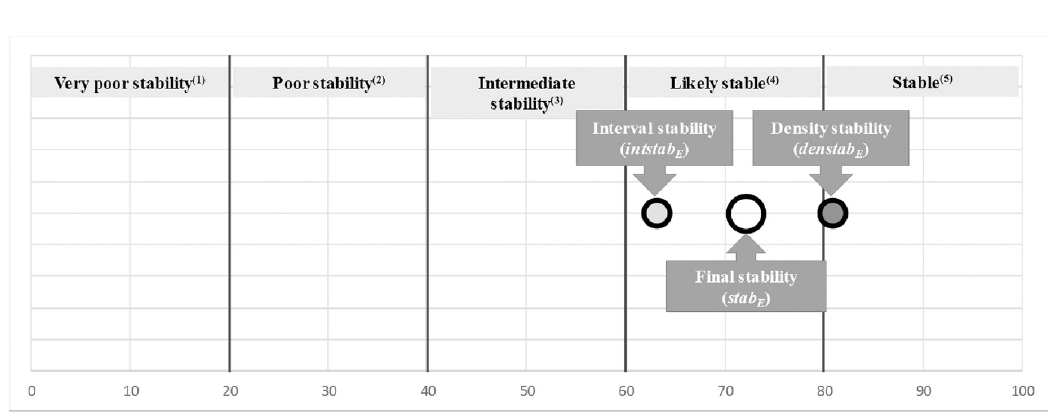
Fig 4. Interval stability ( intstab = 80.95, circle with the darker background), density stability ( denstab E light grey) and final stability ( stab E = 72.04, greater circle without any background colour) for the DMU shown in the example = 0.5 and w = 0.5). (1) Small changes in data values (generated by the Monte Carlo simulation engine or (DMU E) in Fig 3 ( w int den real ones) can change RTE scores dramatically. Decision makers should be awarded. (2) Small changes in data values (generated